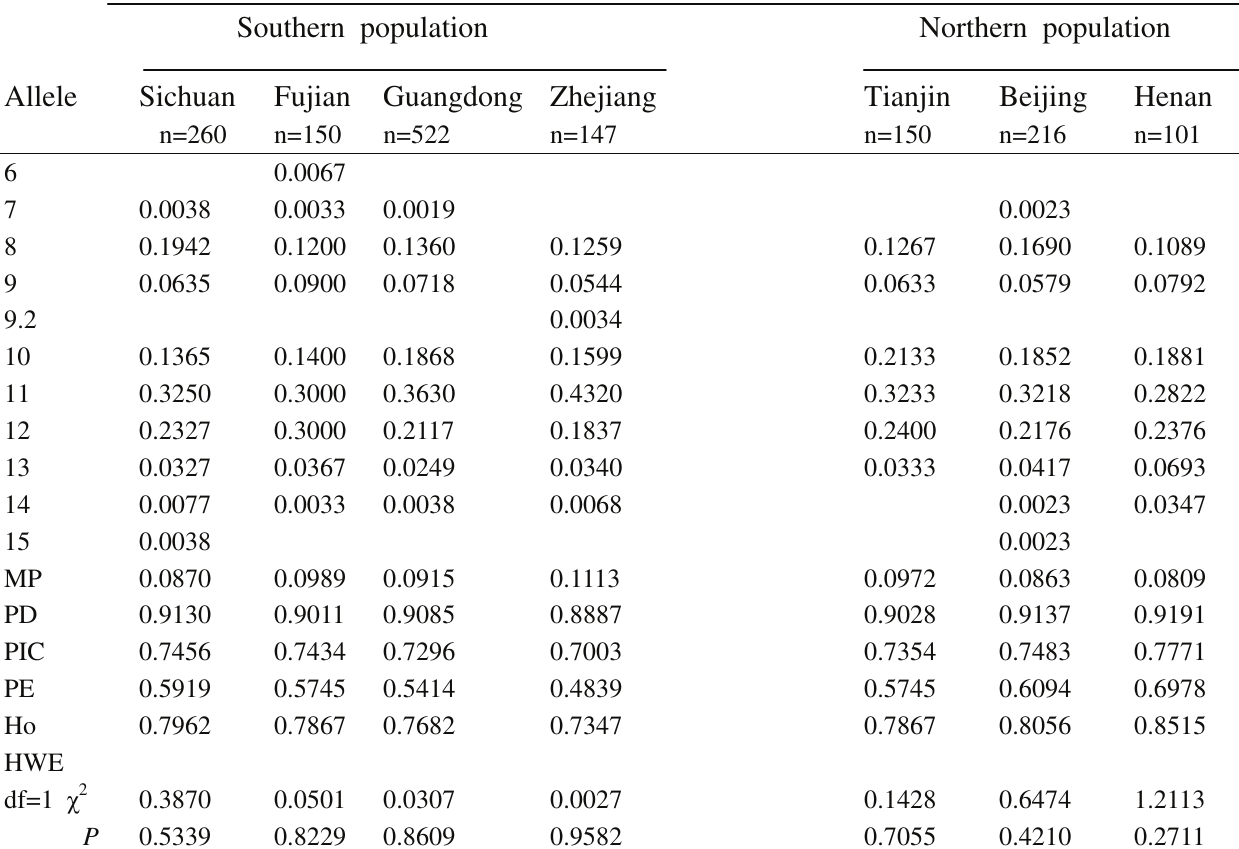
Table S6- Genetic polymorphism at the D7S820 locus for the seven Chinese population groups.